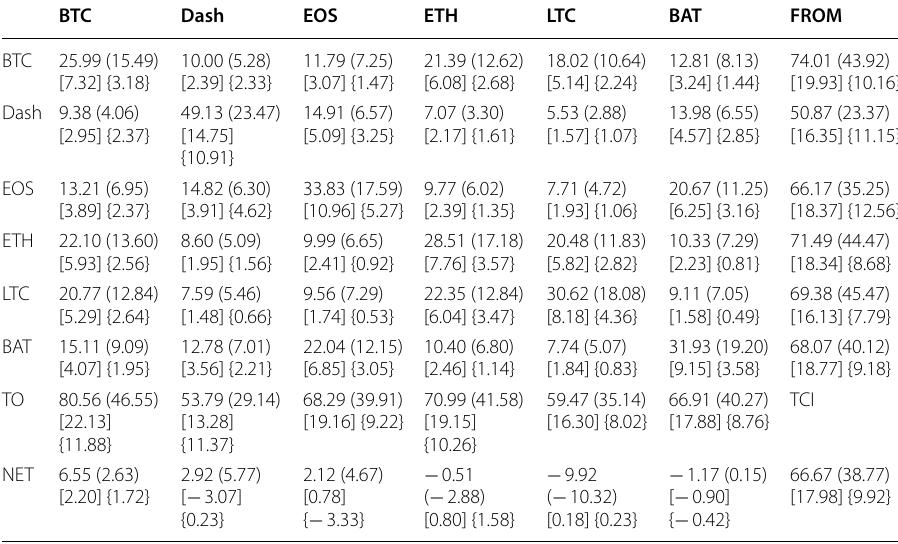
Table 7 Averaged connectedness